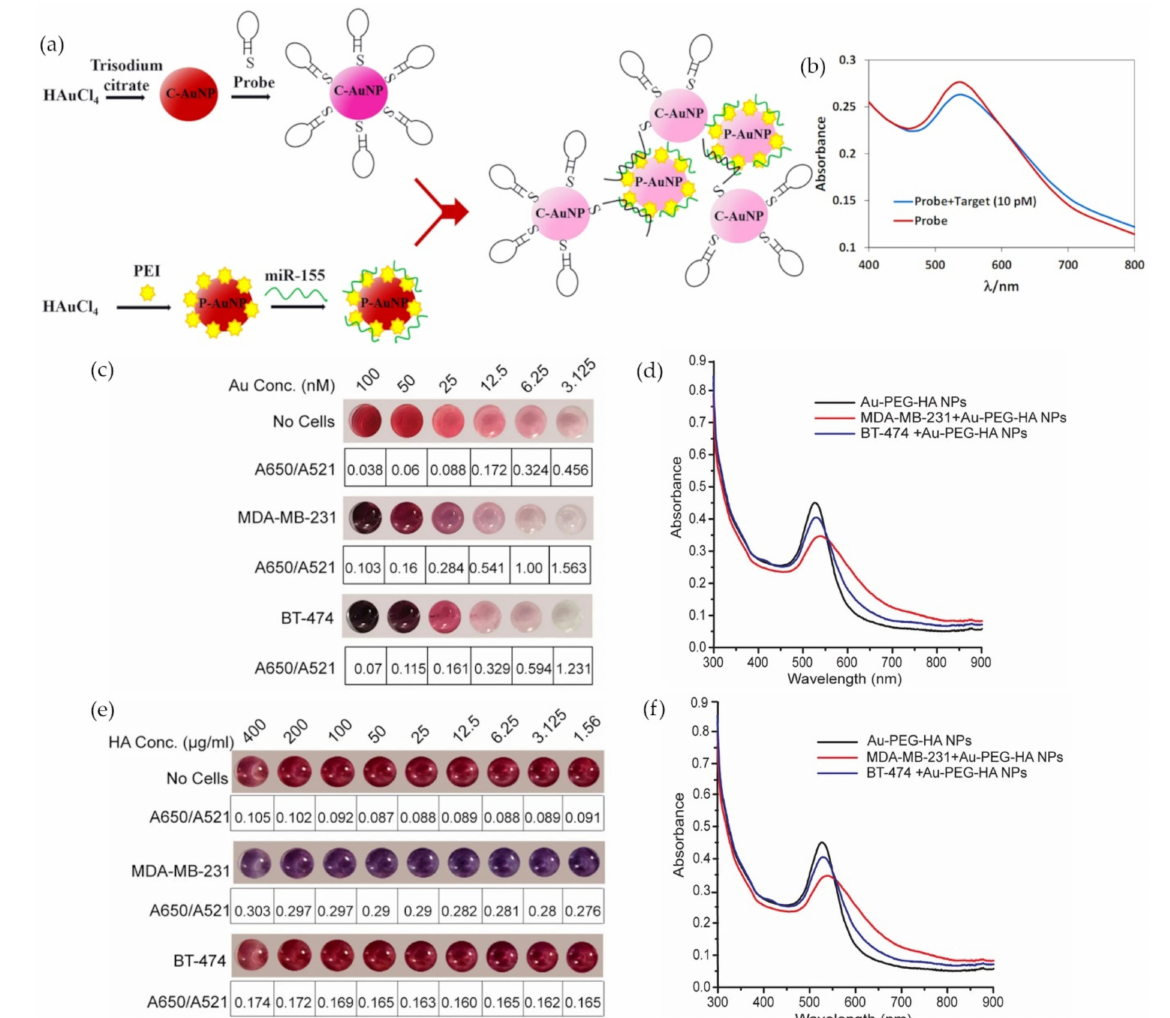
Figure 4. Gold nanoparticle (AuNPs)-based colorimetric assays: ( a ) Schematic of miRNA-155 detection probes; ( b ) UV-Vis spectra curve of the detection probes in the absence (red) and presence (blue) of miRNA-155; ( c ) colorimetric changes and A650/A521 ratio of Au-polyethylene glycol- hyaluronic acid (HA) NPs after incubation with 50,000 cells (MDA-MB-231 and BT-474) at varied Au concentrations; ( d ) UV-Vis spectra of Au-polyethylene glycol-HA NPs after incubation with MDA-MB-231 (50,000 cells) and BT-474 (50,000 cells) at 25nM Au concentration; ( e ) colorimetric changes and A650/A521 ratio of Au-polyethylene glycol-HA NPs after incubation with MDA-MB-231 (50,000 cells) and BT-474 (50,000 cells) at varied HA concentrations and 25nM Au; ( f ) UV-Vis spectra of Au-polyethylene glycol-HA NPs after incubation with 50,000 cells (MDA-MB-231 and BT-474) at 100 HA µ g/ml and 25 nM Au concentrations. (Reproduced with permission from [35] and from [36], published by Springer Nature